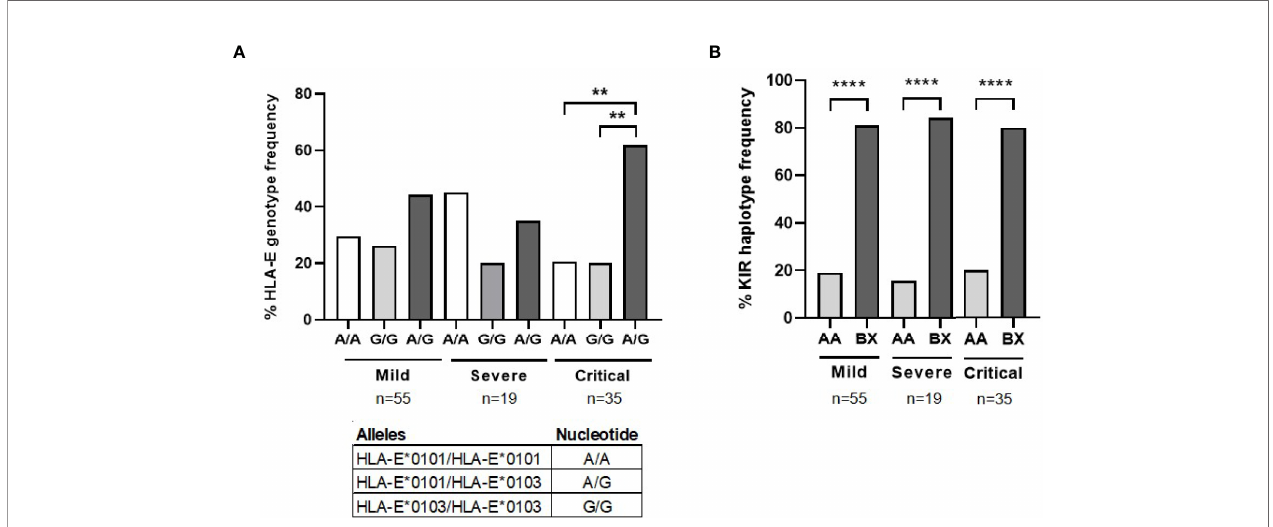
FIGURE 5 | HLA-E and KIR genotyping in patients with different presentations of COVID-19. (A) Analysis by qPCR of the percentage of HLA-E genotyping and alleles frequency in patients with severe (n=19) and critical (n=35) COVID-19, in comparison with patients with mild COVID-19 (n=55). (B) Analysis of the percentage of KIR alleles and haplotypes frequency in the same patients. Statistical signi fi cance was calculated using one-way ANOVA and Tukey ’ s multiple comparisons test. **p < 0.01; ****p <